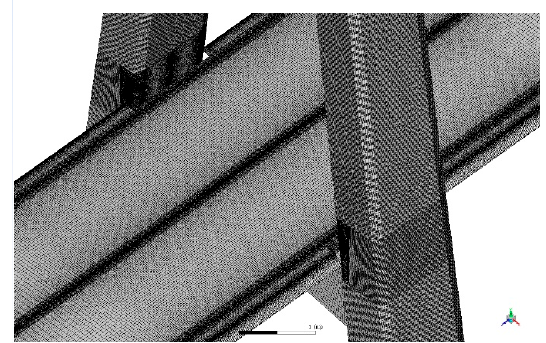
Figure 6. Near wall